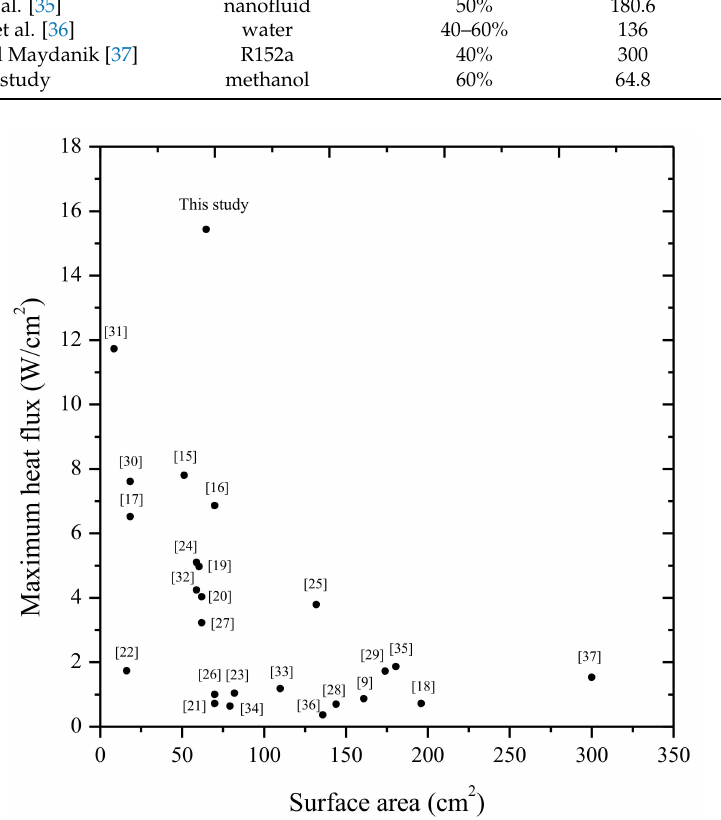
Figure 11. Comparison of the maximum heat flux vs. surface area of the present study against existing